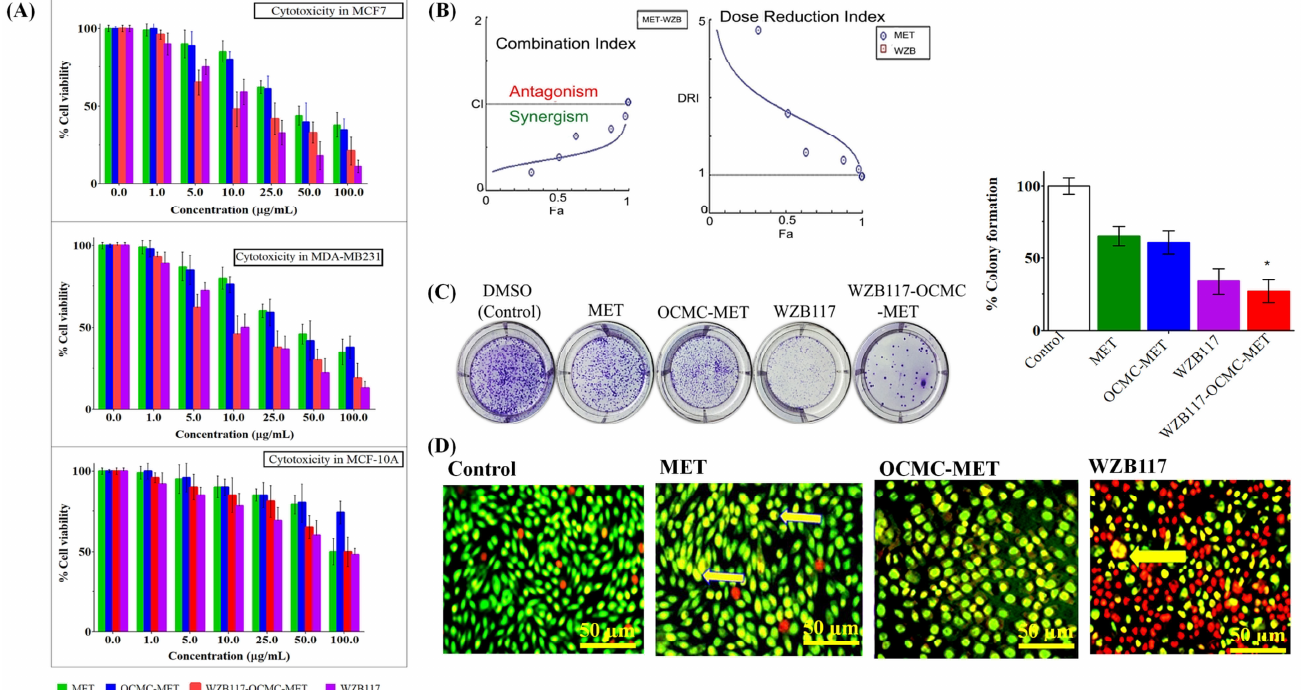
Figure 4. ( A ) Cytotoxicity studies in MCF7, MDA-MB-231, and MCF10A cell lines in vitro. ( B ) Graphical representation of CompuSyn ® software data for MET and WZB117 CI and DRI plots. ( C ) MDA-MB-231 cell line colony formation assay 1. Untreated cells (control); 2. cells treated with MET; 3. cells treated with OCMC-MET; 4. cells treated with WZB117; and 5. cells treated with WZB117-OCMC-MET. The group ( p < 0.01) after the treatment. ( D ) Morphological changes of the MDA-MB-231cancer cells